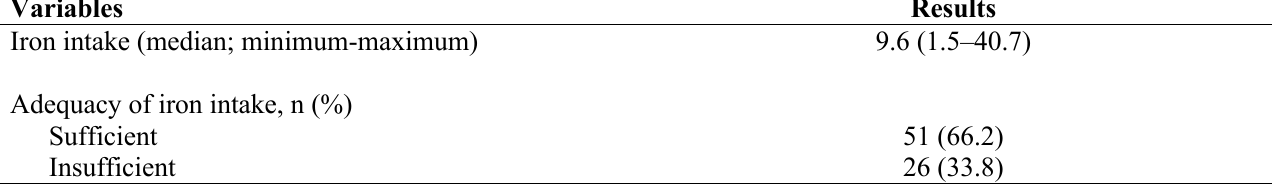
Table 2 . Subjects’ iron intake